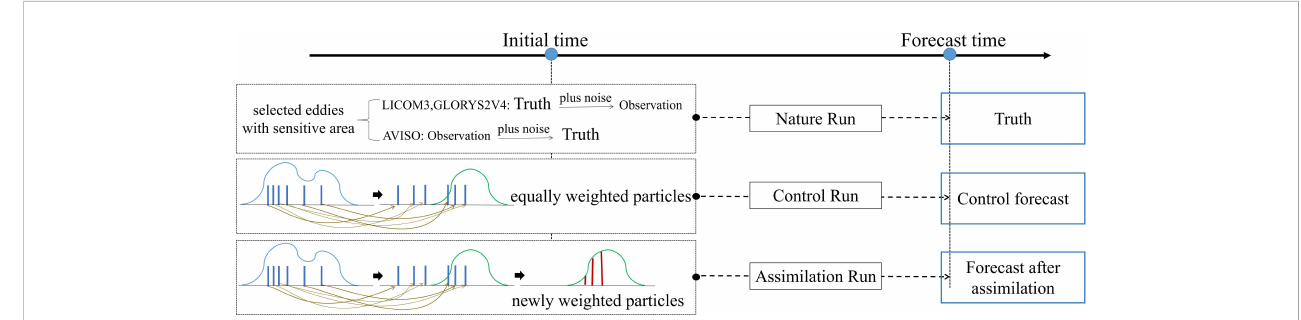
FIGURE 1 A diagram showing the validation scheme. The prior PDF (blue thin curve) of a system is sampled by a number of particles at the initial time, which are indicated by the blue vertical bars. These particles are all propagated forward in time, indicated by the brown lines. In the Control Run, the equally weighted particles make up an ensemble mean forecast, i.e., the control forecast in the fi gure; in the Assimilation Run, a group of newly weighted particles (red vertical bars) is obtained through the PF assimilation method using the observation information (green thin curve), and the ensemble mean of the newly weighted particles constitutes an updated forecast, i.e., the forecast from the assimilation. The comparison between the improvement of the Assimilation Run and that of the Control Run against the Nature Run would reveal the usefulness of assimilated observations, where the Nature Runs are obtained by taking the model runs for the LICOM3 and GLORYS2V4 reanalysis data and superimposing the noise to the observation for the